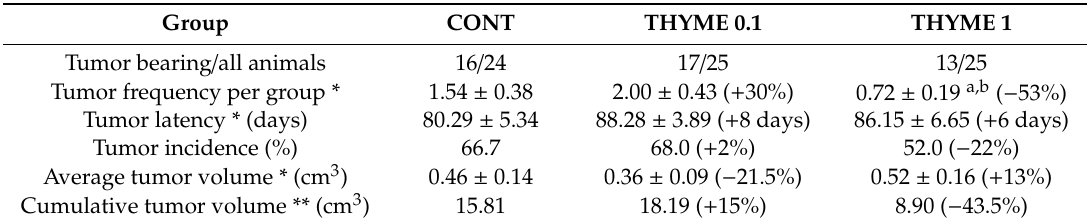
Table 1. E ff ects of T. vulgaris in N -methyl- N -nitrosourea-induced mammary carcinogenesis in female Sprague-Dawley rats at the end of experiments.